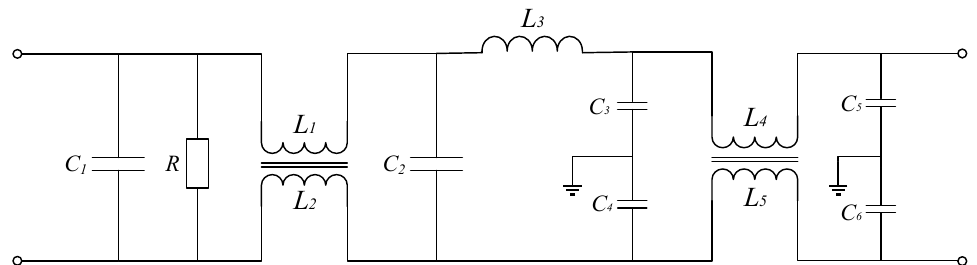
Figure 2. EMI filter to be identified.